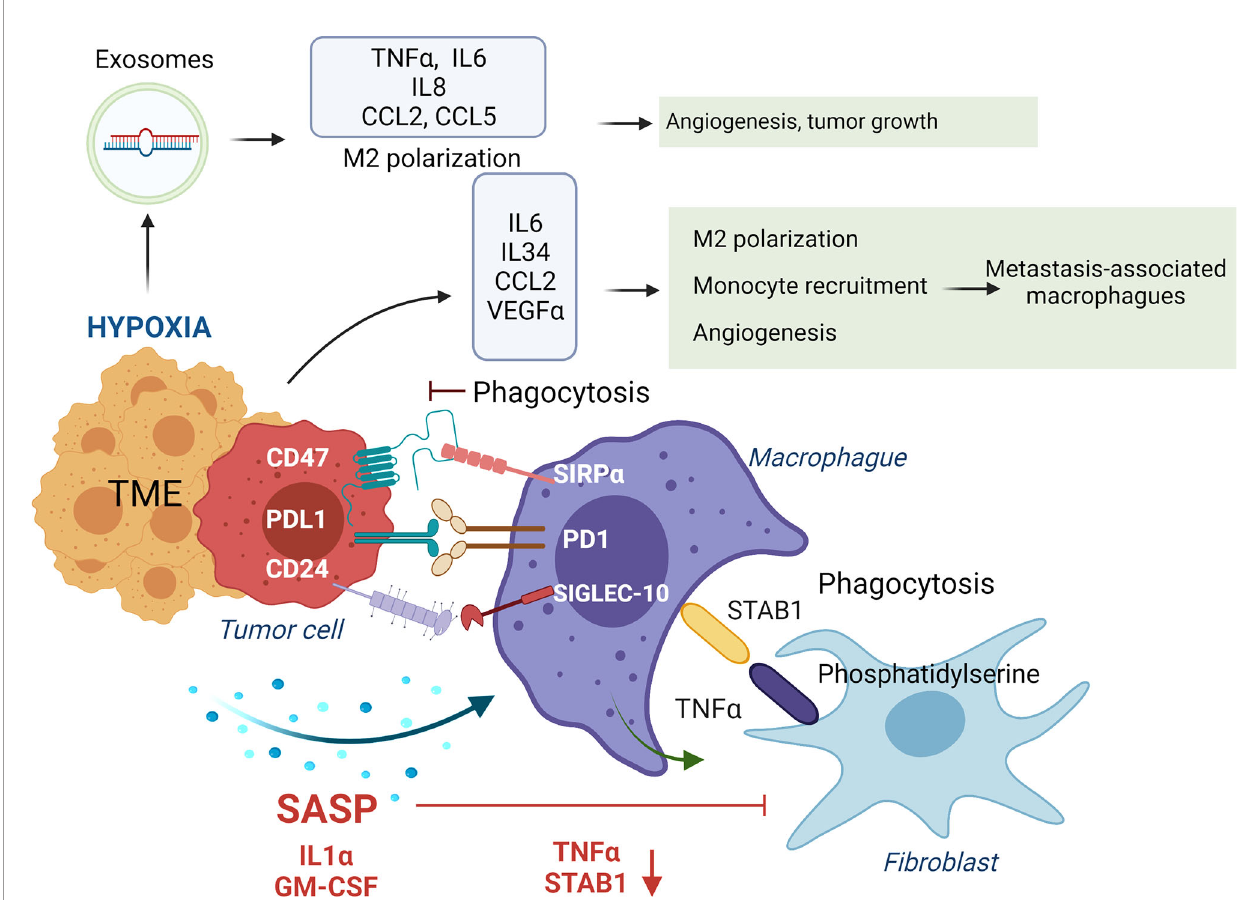
FIGURE 4 | Impact of tumor secretome inthe phagocyticactivity of macrophages. In healthy conditionsmacrophages phagocyte transformed cells andsenescent fi broblasts to maintaintissue homeostasis. Normally,macrophages, through release ofTNF a , induce apoptosisin senescent fi broblasts, leadingto expression of phosphatidylserine intheir surface, which isrecognized bySTAB1 on macrophages to promote their phagocytosis. In advanced stages of senescence, phagocytic activity of macrophages isinhibited by over-expression of ligandsofimmune-checkpoints (CD47, PDL-1 and CD27)thatinteract with theirreceptors onmacrophages (SIRP a , PD1 andSIGLEC-10).Moreover,SASP factors, includingIL1 a andGM-CSF, down-regulate STAB1 andTNF a expression,avoiding the phagocytosis of senescent fi broblasts by macrophages. In addition,IL6, IL34, CCL2and VEGFa secretion inthe TME, induce M2macrophage polarization andrecruitment of in fl ammatory monocytes that polarize to metastasis-associated macrophages that insummary promote tumorgrowth. Hypoxia inestablished tumorsalso promotes the release of exosomes containingthe miRNAs miR-301a-3p and miR-21 that promote M2polarization,and TNF a , IL6, IL8, CCL2 and CCL5secretion impactinginhigher angiogenesis, and tumor